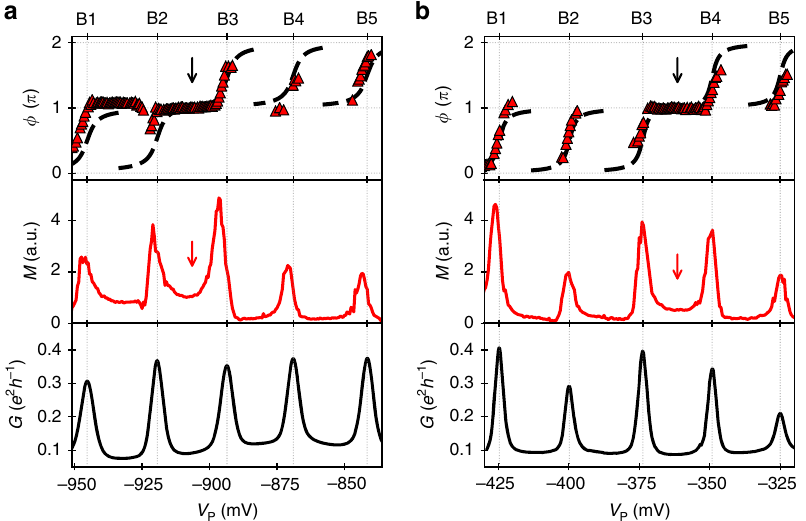
Fig. 5 Effect of quantum dot deformation on the transmission phase. Transmission phase, ϕ , magnitude of AB oscillation, M , and electrical conductance at lower terminal, G , along the same set of resonances (B1 – B5) for different quantum dot con fi gurations: a reference con fi guration with V DL = V DR = − 0.92V. b Deformed quantum dot with V DL = V DR = − 1.08 V. The deviating intervals of V P in a , b result from the different gate voltage applied to the gates V DL and V – B5, are shown. The dashed line underneath the transmission phase data serves as guide to DR and have been chosen such that the same resonances, B1 the eye and is constructed on the basis of conductance peak data shown in the bottom panel. The black arrows indicate the absence of phase lapses. The red arrows indicate regions of enhanced AB oscillation coinciding with phase plateaus